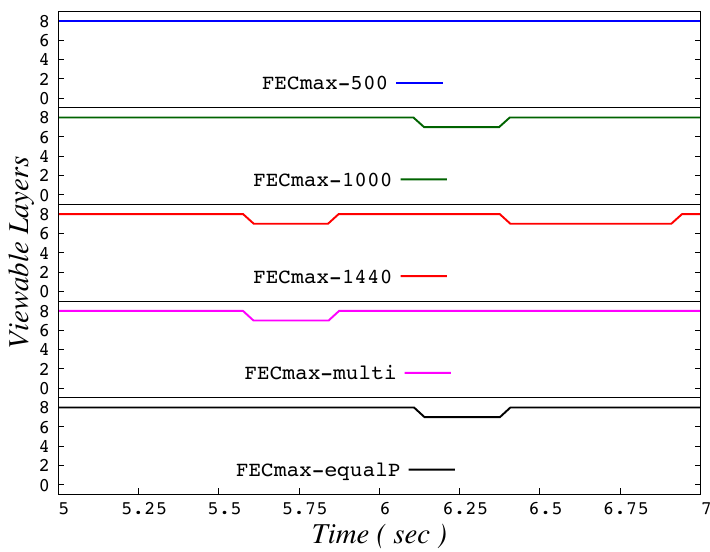
Figure A15. A two-second example of variation in viewable quality for all FEC max models, at a packet loss rate of 10% and a GOP of 8. This illustrates an increase in the FEC max for C1 and C2 based on the worst case scenario, as shown in Table A2.